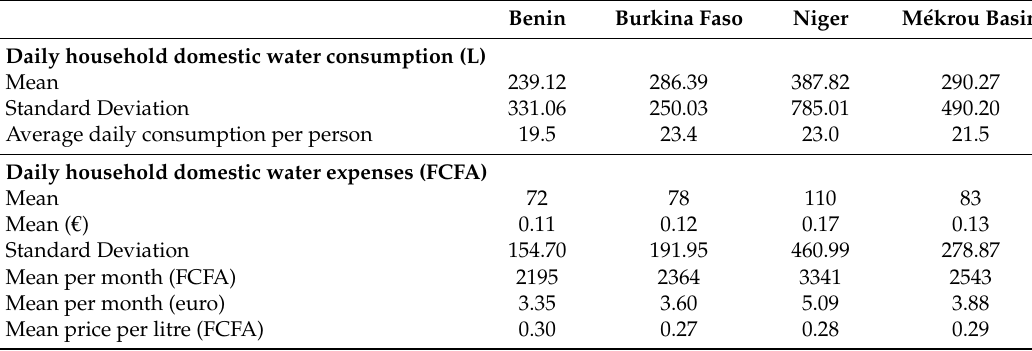
Table 6. Daily household domestic water consumption and expenses (including all